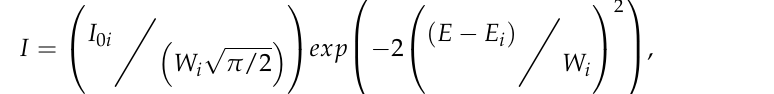
Table 3. Fit parameters from Equation (4). The error of E i and W i ( i = 1–9) determination is ±0.03 eV. The error of the I 0i ( i = 1–9) determination is ±3 arb. units.